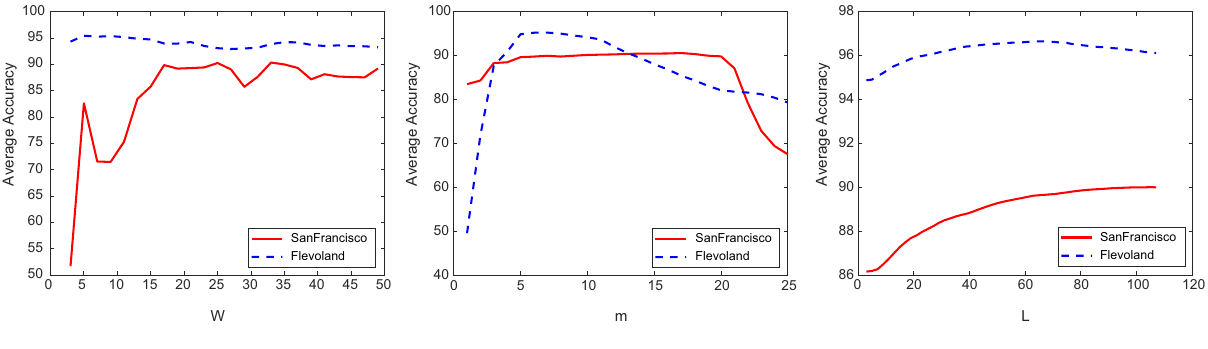
Figure 1. Average classification accuracy versus the free parameters ( W , m and L ) of